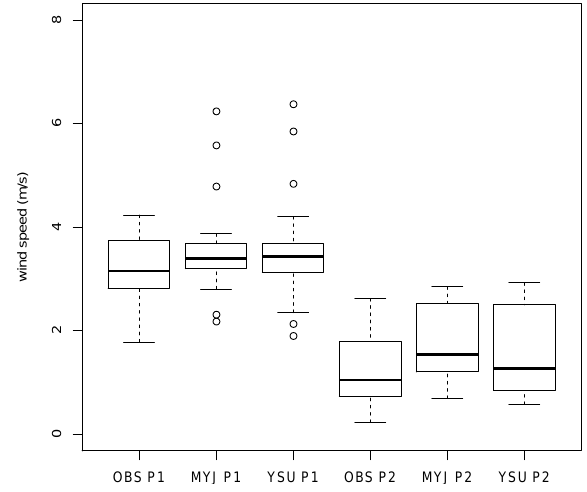
Figure 12. Comparison of observed (OBS) and simulated 20m wind speed by STILT/MYJ (MYJ) and STILT/YSU (YSU) both using KED optimized MHs at Cabauw. Results are shown for pe- riod (P1) and period 2 (P2) shown as grey stripes in Fig. 9. Boxes denote the central 50% of the data, whiskers are at ± 1.5 times the inter-quantile range and outliers are shown as open circles. Black line within boxes indicate the median